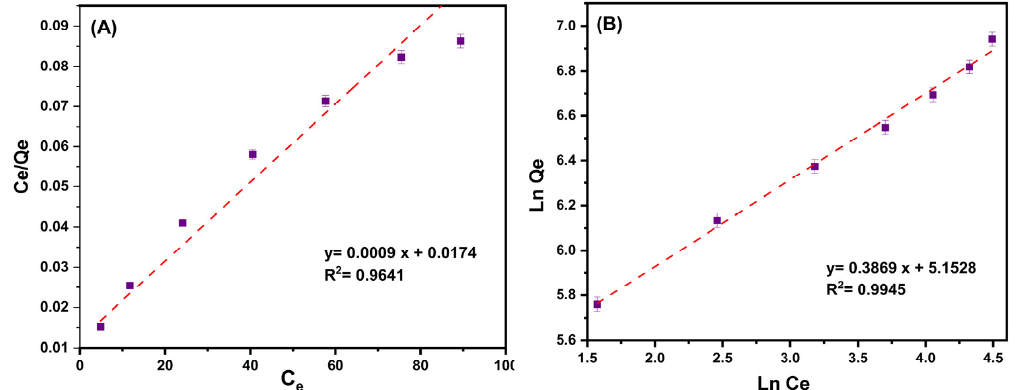
Figure 8. ( A ) The plot of the ratio of the equilibrium concentration of ciprofloxacin (C e , mg/L)/equilibrium adsorption capacity (Q e , mg/g) to the equilibrium concentration of ciprofloxacin (C e , mg/g) [Langmuir isotherm]. ( B ) The plot of the Ln of equilibrium adsorption capacity (Q e , mg/g) to the Ln of the equilibrium concentration of ciprofloxacin (C e , mg/g) [Freundlich isotherm]. Conditions: contact time (5–30 min), pH:7, MMIP dosage (3 mg), ciprofloxacin initial concentration (200 mg/L) and T (298 K). Table 3. Adsorption capabilities of several adsorbents for ciprofloxacin. Method of Adsorbents Determination